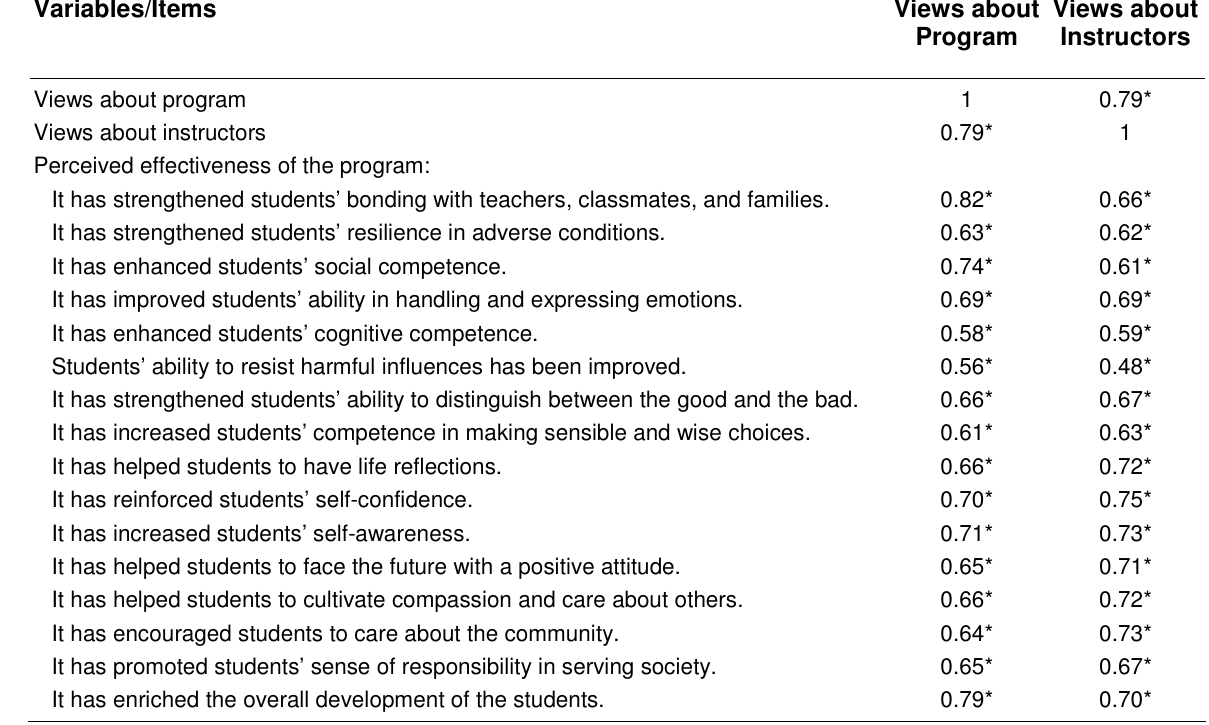
Intercorrelations among Domains in Subjective Outcome